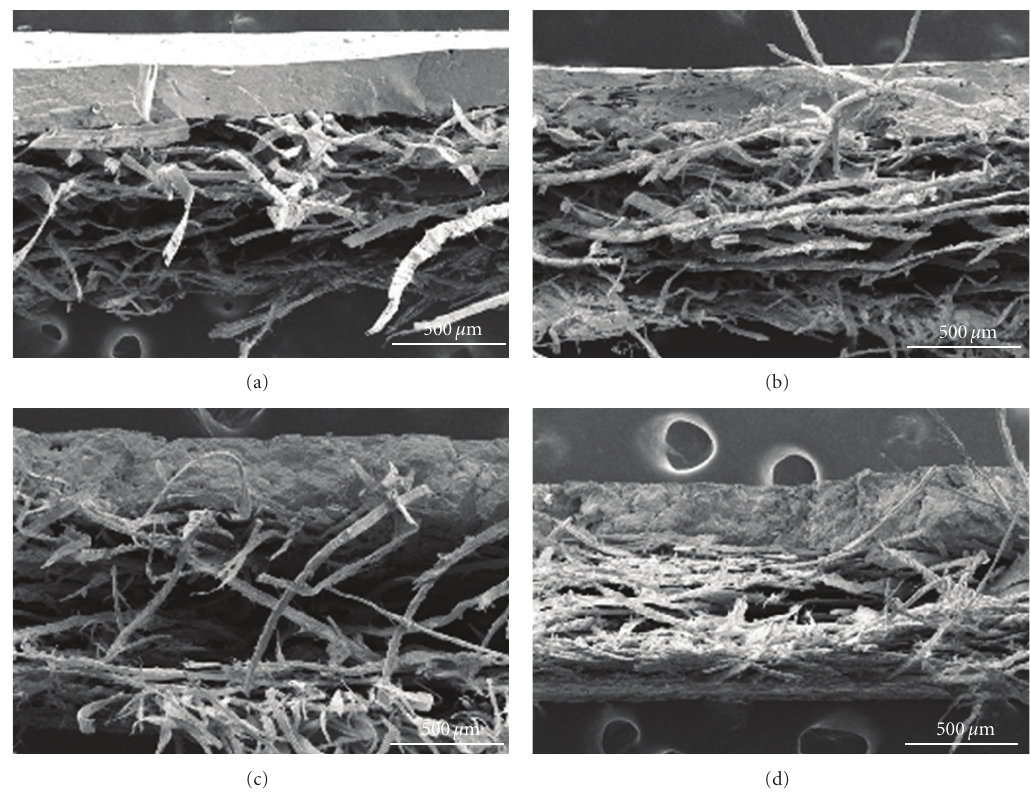
Figure 7: Cross-sections of tensile-fractured samples containing 30wt.% plasticizer with (a) 0 wt.%, (b) 25 wt.%, (c) 50 wt.%, and (d) 75wt.%